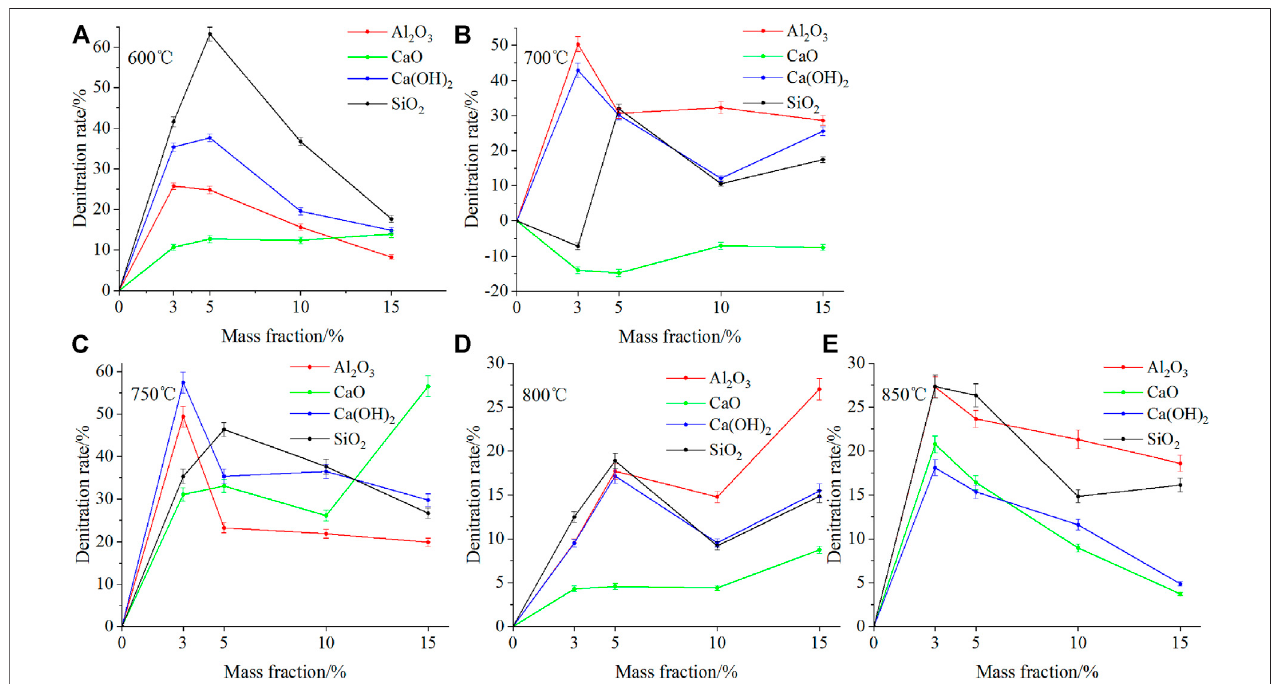
FIGURE 6 | Comparison of denitration rates for different mass fractions of four additives at different temperatures.